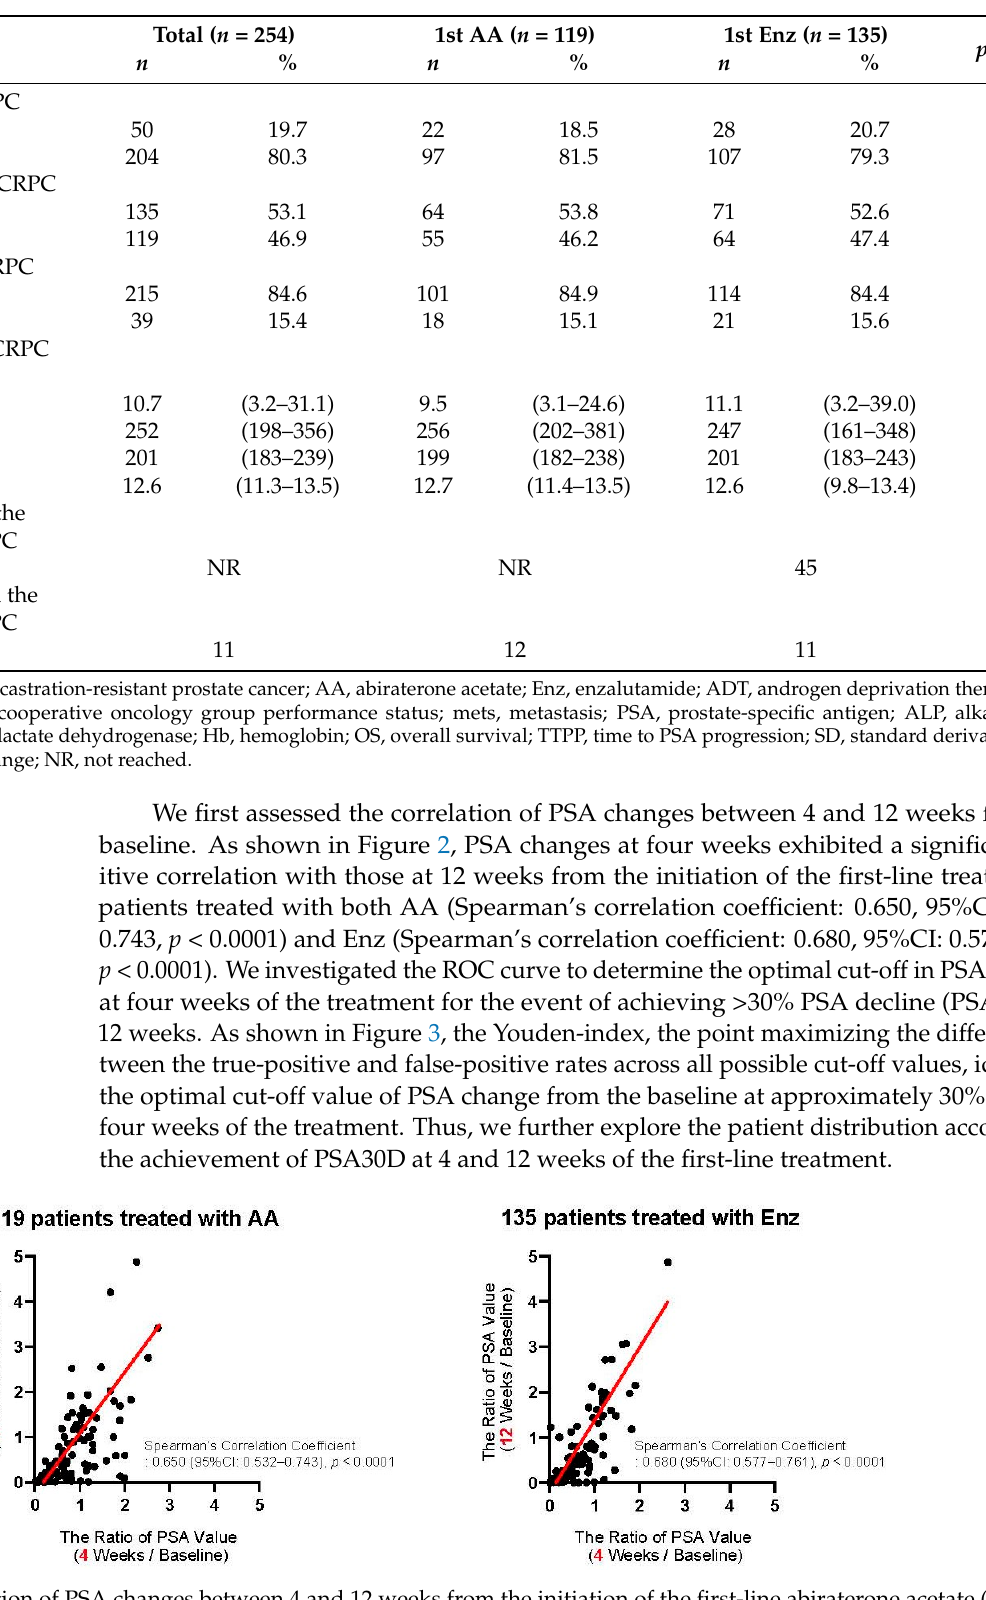
Figure 2. Correlation of PSA changes between 4 and 12 weeks from the initiation of the first-line abiraterone acetate (AA: left panel) and enzalutamide (Enz: right panel). The axis indicates the ratio of PSA value, i.e., (at four weeks/at baseline: X-axis) and (at 12 weeks/at baseline: